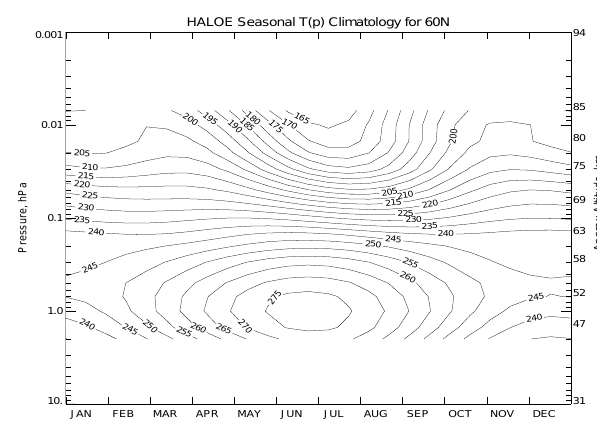
Fig. 8. MLR model fit to the HALOE T (p) time series points at 60N, 0.01hPa.